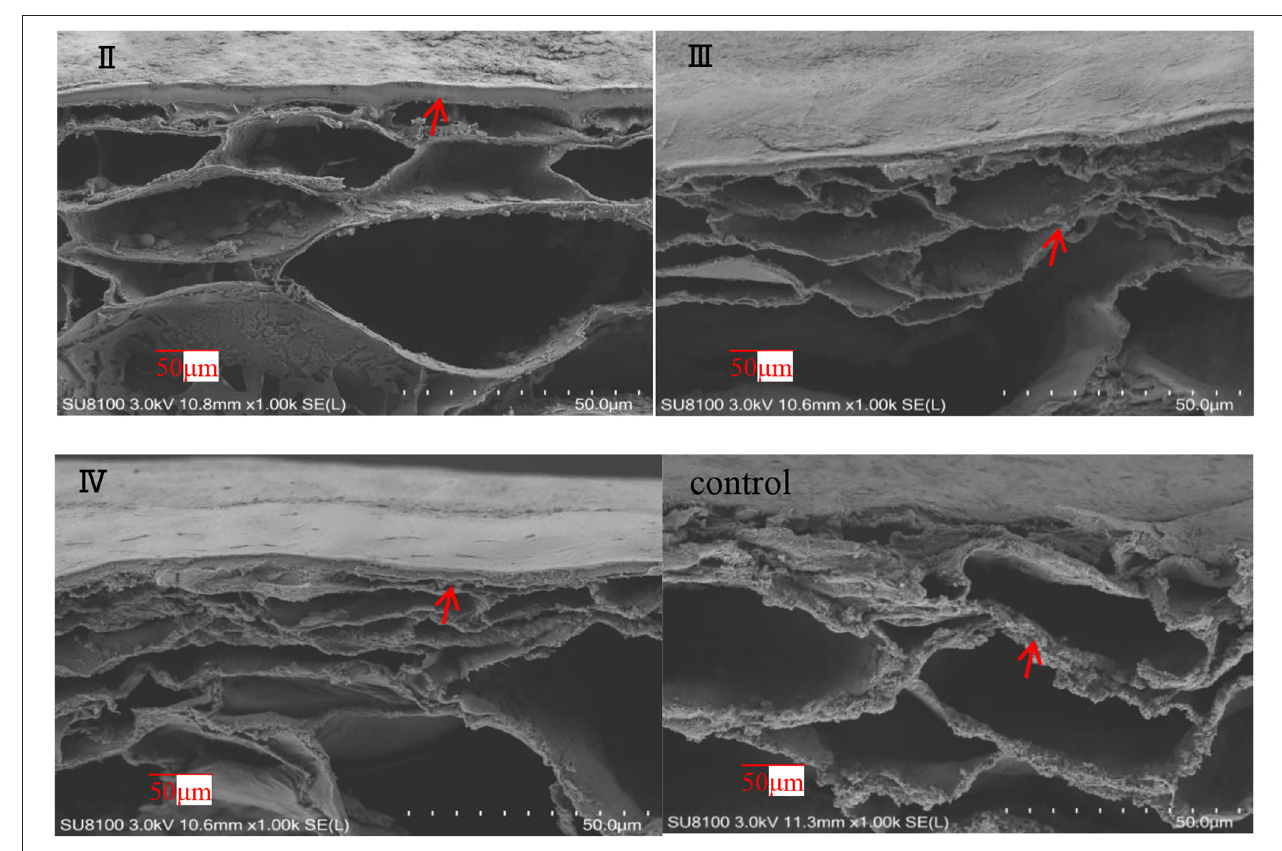
FIGURE 5 | SEM of grape peels with calcium treatment in different stages (II represents ripening grape skins treated with calcium spray at flowering, III represents ripe grape skins treated with calcium spray during fruit development, and IV represents ripe grape skins treated with calcium spray at the end of fruit development) (grape peel, arrows).